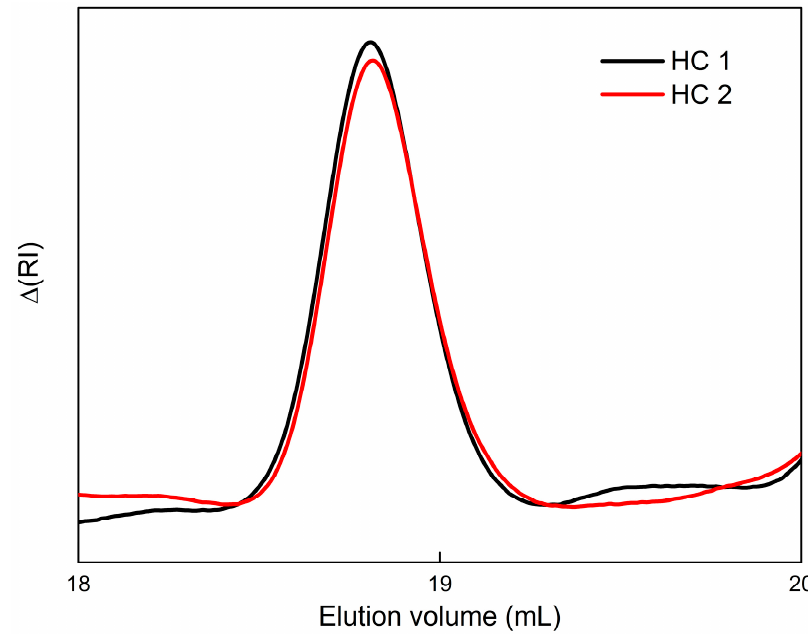
Figure 1. SEC traces of the HCs in DMF.